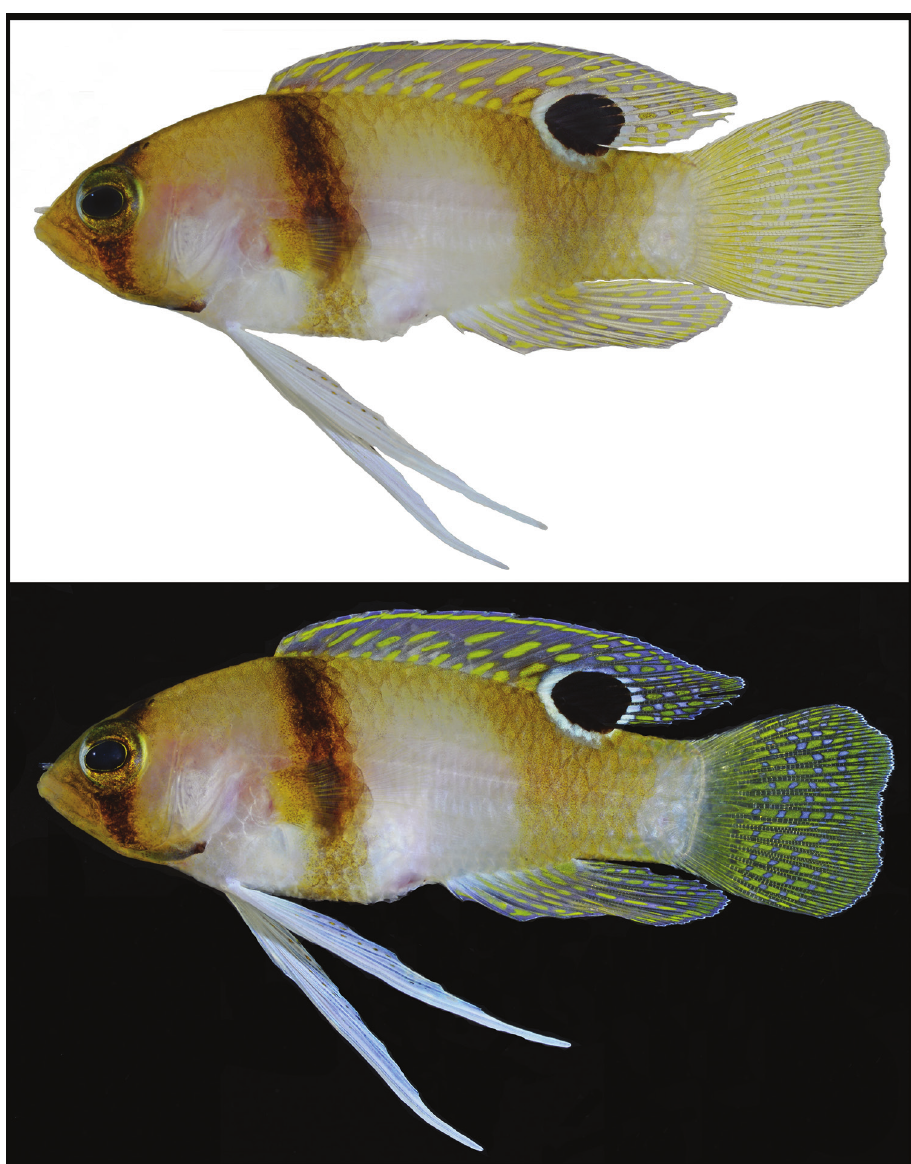
Figure 7. Lipogramma haberi sp. n., USNM 422679, holotype, 40.1 mm SL, photographed prior to preservation against white (top) and black (bottom) backgrounds. Photos by D. R. Robertson and C. C.